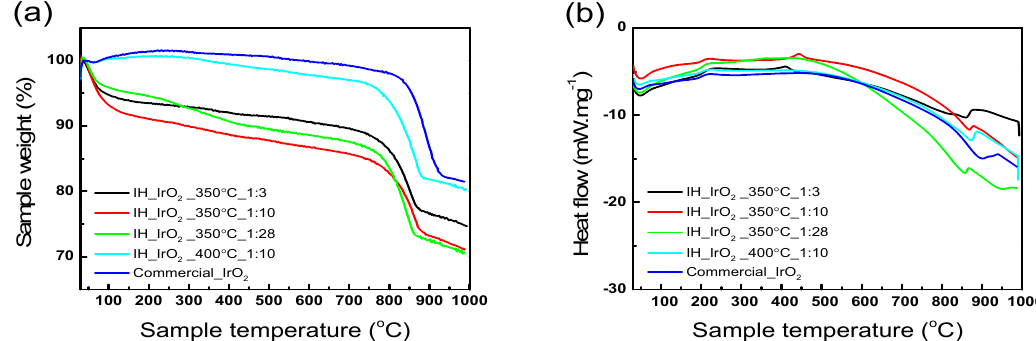
Figure 3. ( a ) Thermal gravimetric analysis (TGA) and ( b ) Differential thermal analysis (DTA) of in-house and commercial_IrO 2 . Table 2. Percentage weight loss during thermal gravimetric analysis (TGA).